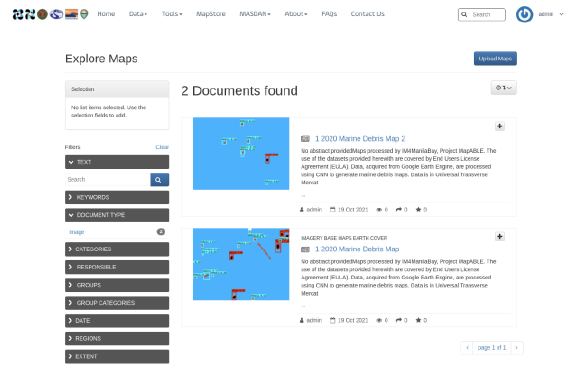
Figure 10. 2020 Marine debris maps shown in the Data/Maps page of the MapABLE Web Portal.